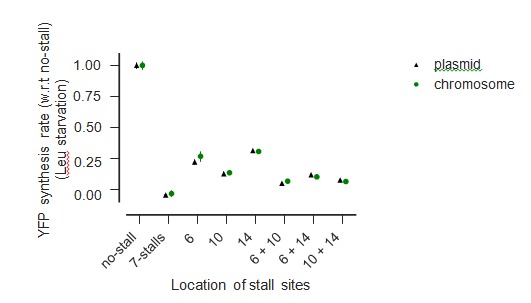
Comparison of measured YFP levels when expressed from chromo- some and plasmid during Leu starvationDOI: